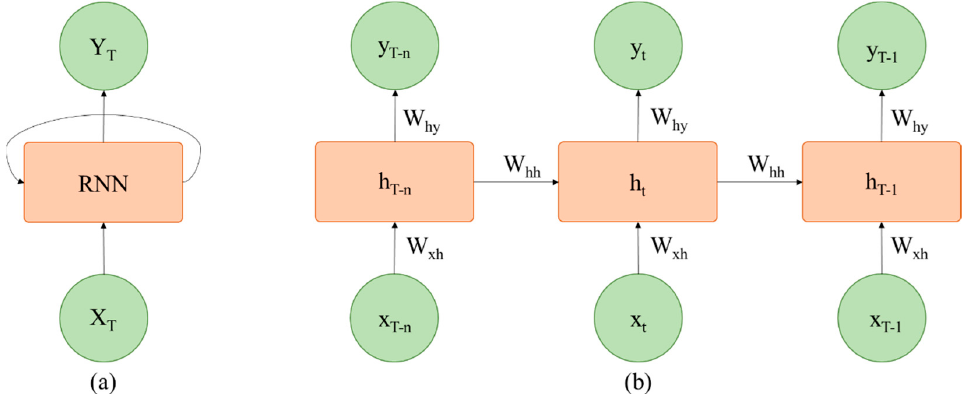
Figure 2. Sequential model architecture with the loop concept, where ( a ) shows a standard structure, and ( b ) represents an unfolded RNN architecture.